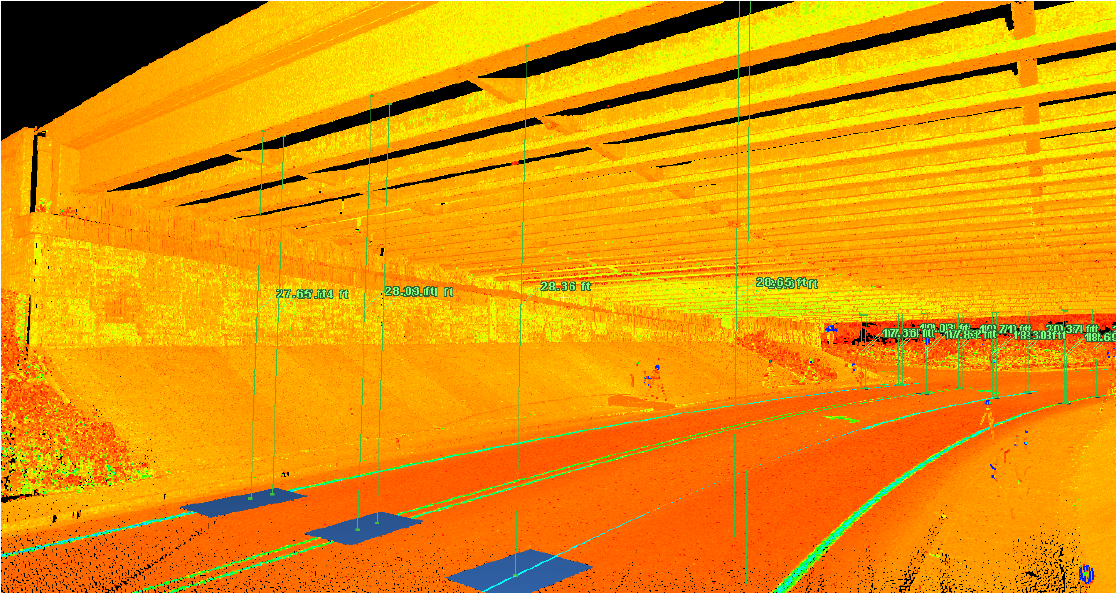
Figure 9. Clearance values measured perpendicular to roadway surface using a static scan point cloud (Courtesy of Oregon DOT).